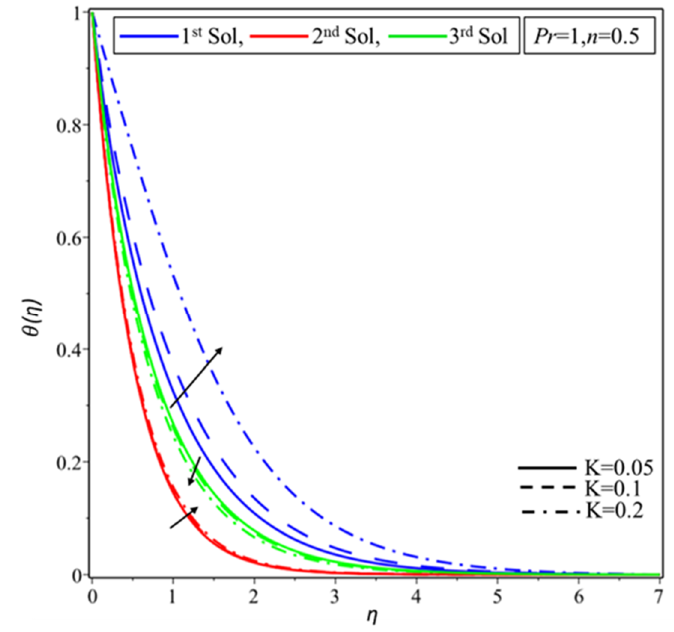
Figure 9. E ff ect of K on θ ( η ) when S = 2.5. Crystals 2020 , 10 , x FOR PEER REVIEW Figure 9. Effect of K on (cid:2016)((cid:2015)) when S = 2.5.